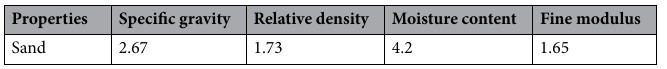
Table 3. Physical properties of the milled sand.